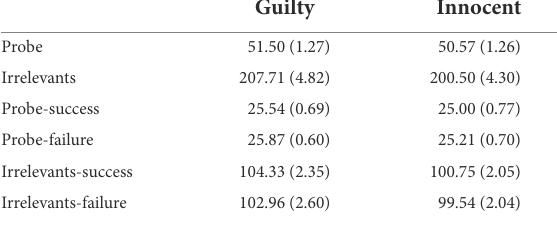
TABLE 1 The number of averaged trials (SE) in each condition.